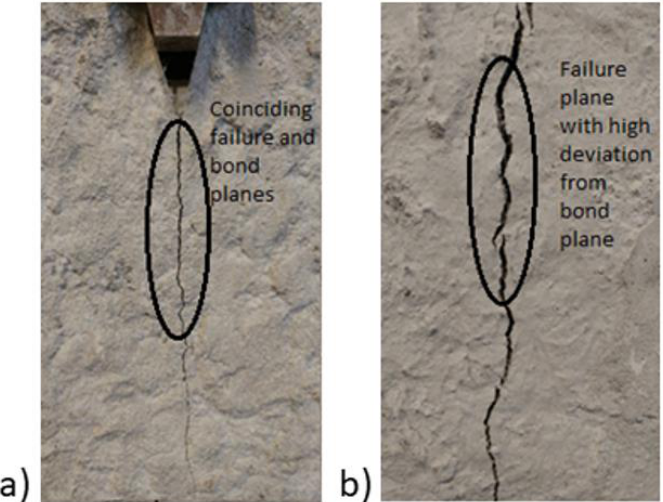
Figure 9. Representative failures of the interface for ( a ) lower crack deviation and ( b ) higher crack deviation.